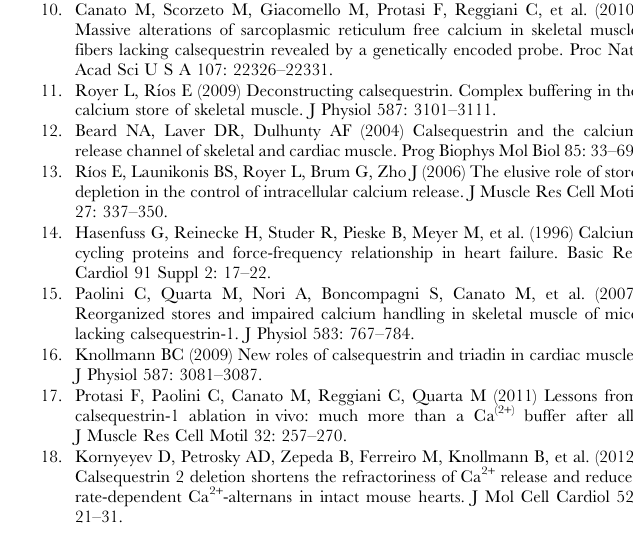
FCSQ Dog CSQ2 Salt Bridge Distance (A˚) U(r)